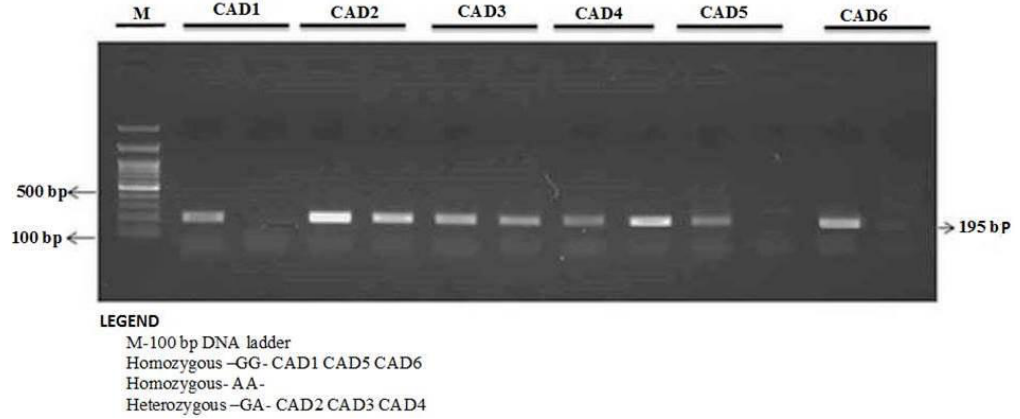
Figure 3. Detection of Omentin-1 rs2274908 G>A gene variation with allele-specific PCR (AS-PCR) in CAD cases.